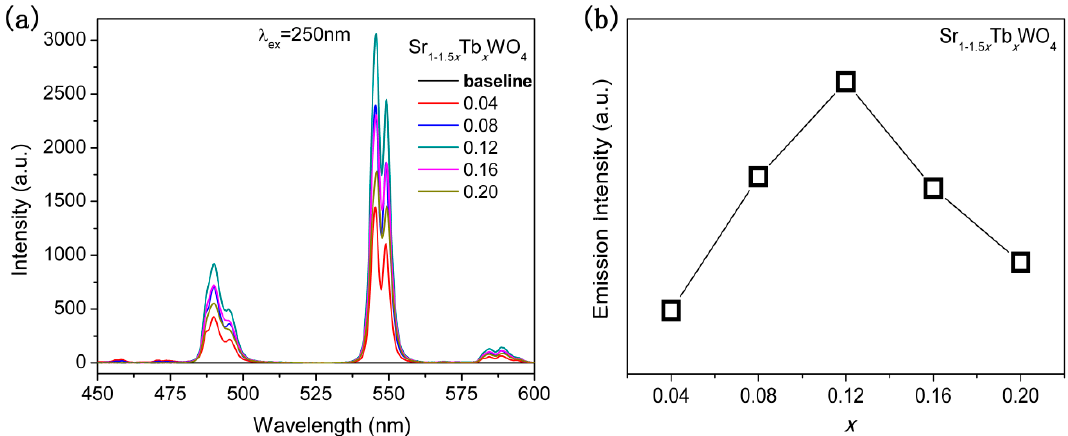
Figure 5. ( a ) The photoluminescence emission spectra of Sr 1 − 1.5 x Tb x WO 4 solid solutions by monitoring at 250 nm. ( b ) The emission intensity of the solid solutions against x .